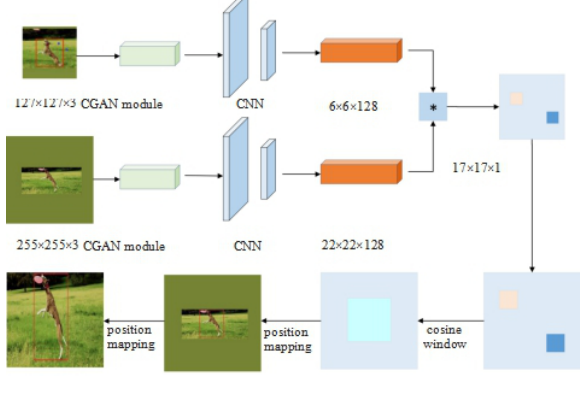
Fig. 1. Structure of